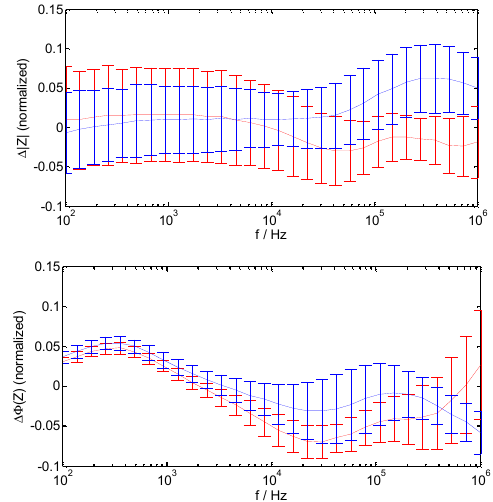
Fig.9: Normalized difference of (a) the impedance magnitude and (b) the phase angle difference between working electrodes with trapped cells and the reference ones. The red line indicates the measurement immediately after trapping the cells and the blue line was obtained 5 h after incubation. The error bars show the standard deviation of 7 electrodes. The 7th out of the 8 electrodes did not trap a cell. It is therefore not shown and omitted in the calculation.